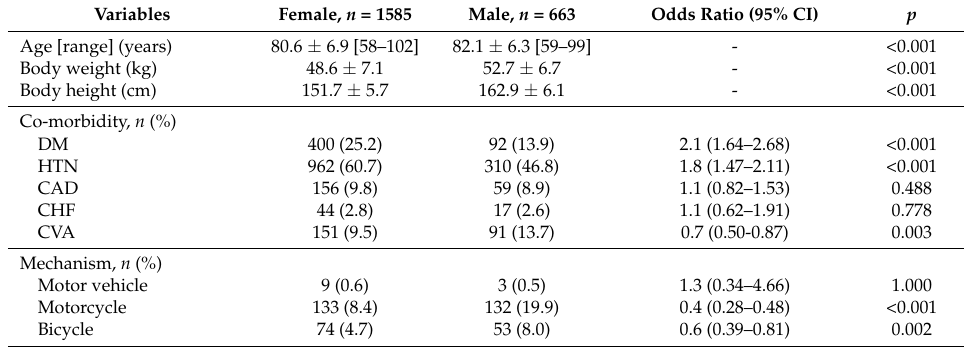
Table 1. Demographics and injury characteristics of male and female patients with high-risk OSTA